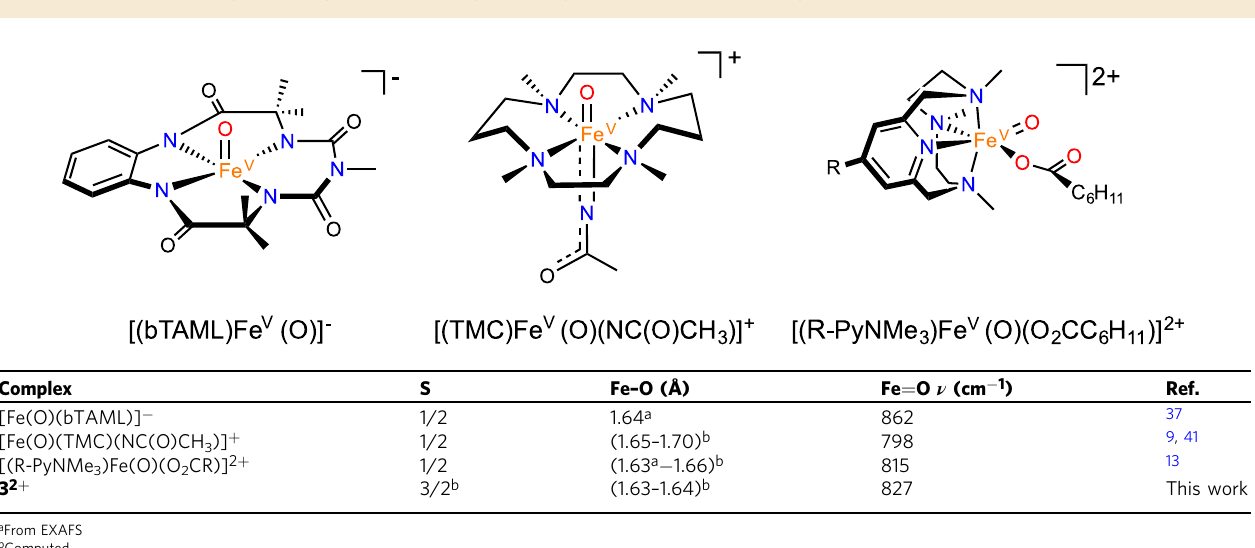
Table 1 Structural and spectroscopic features of previously described Fe V (O)